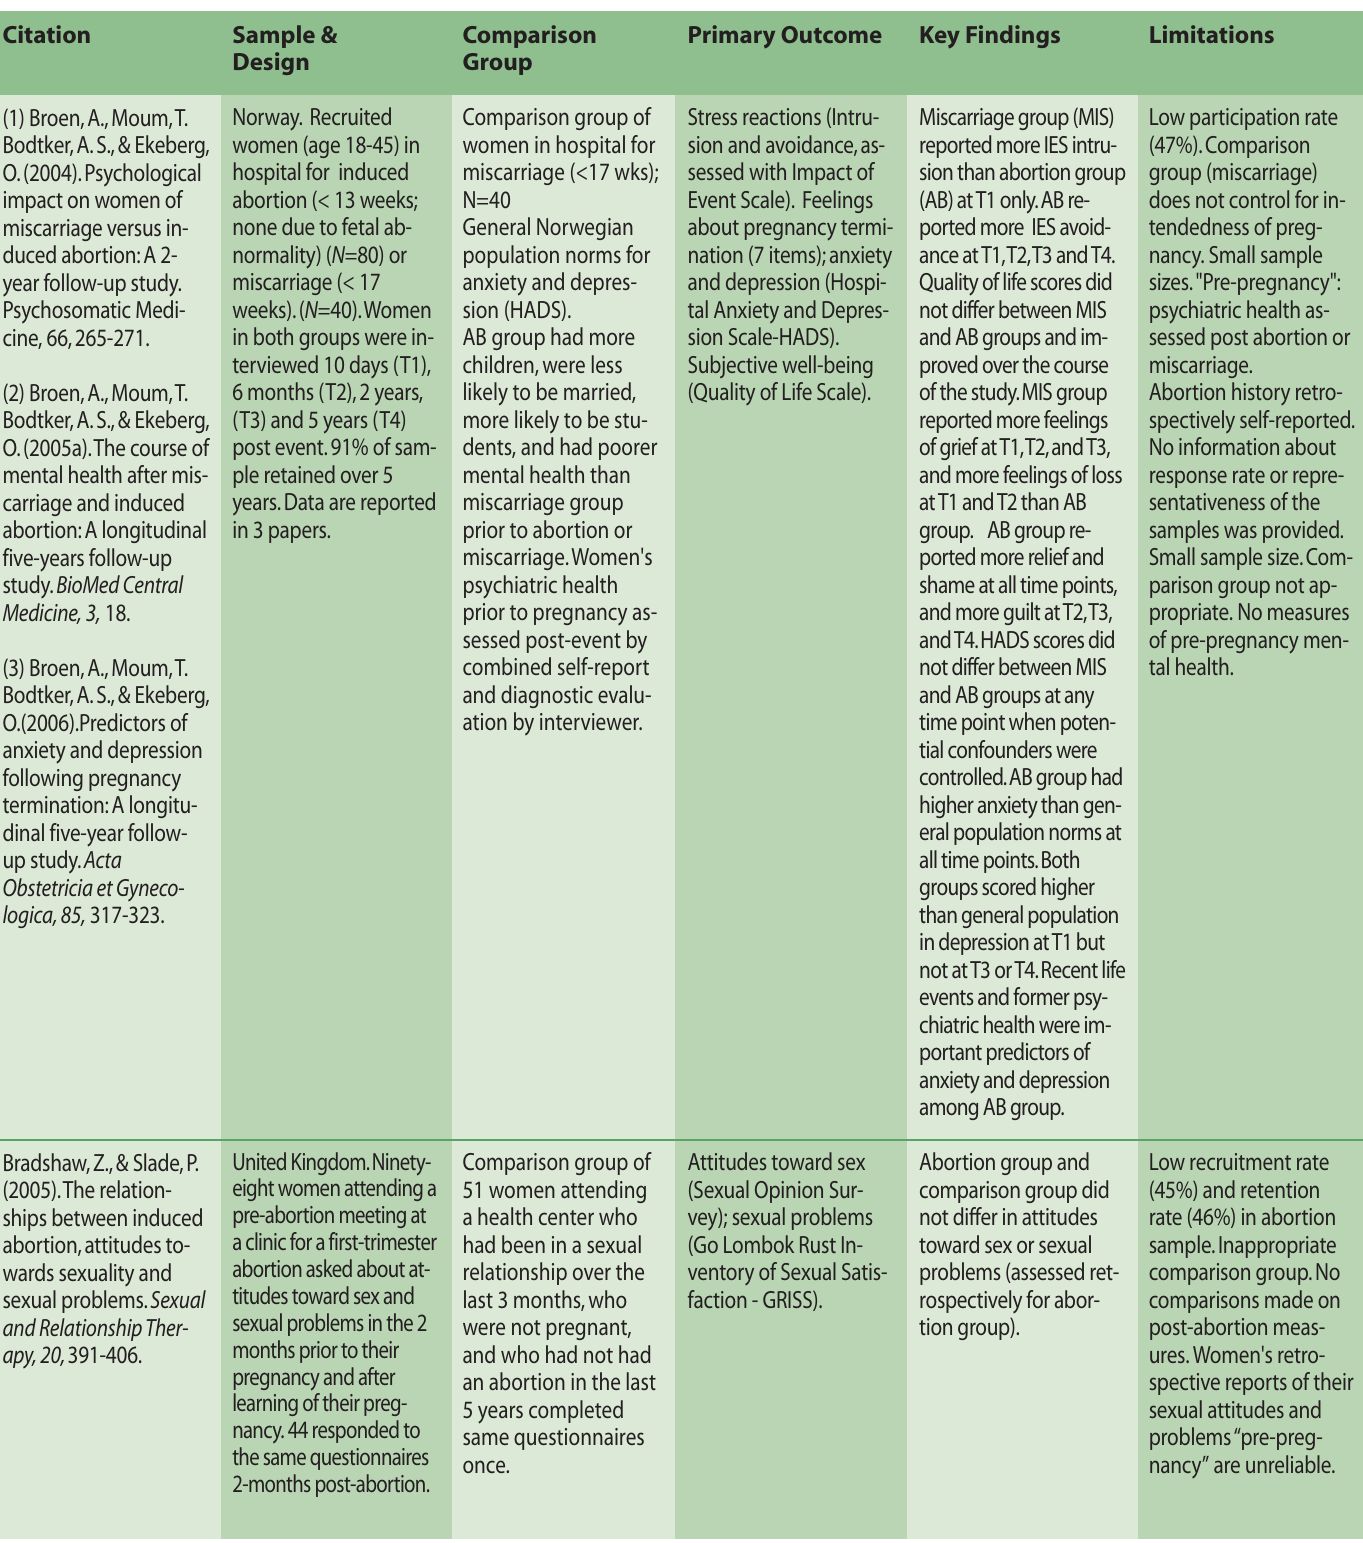
Table 3B: Comparison Group Studies